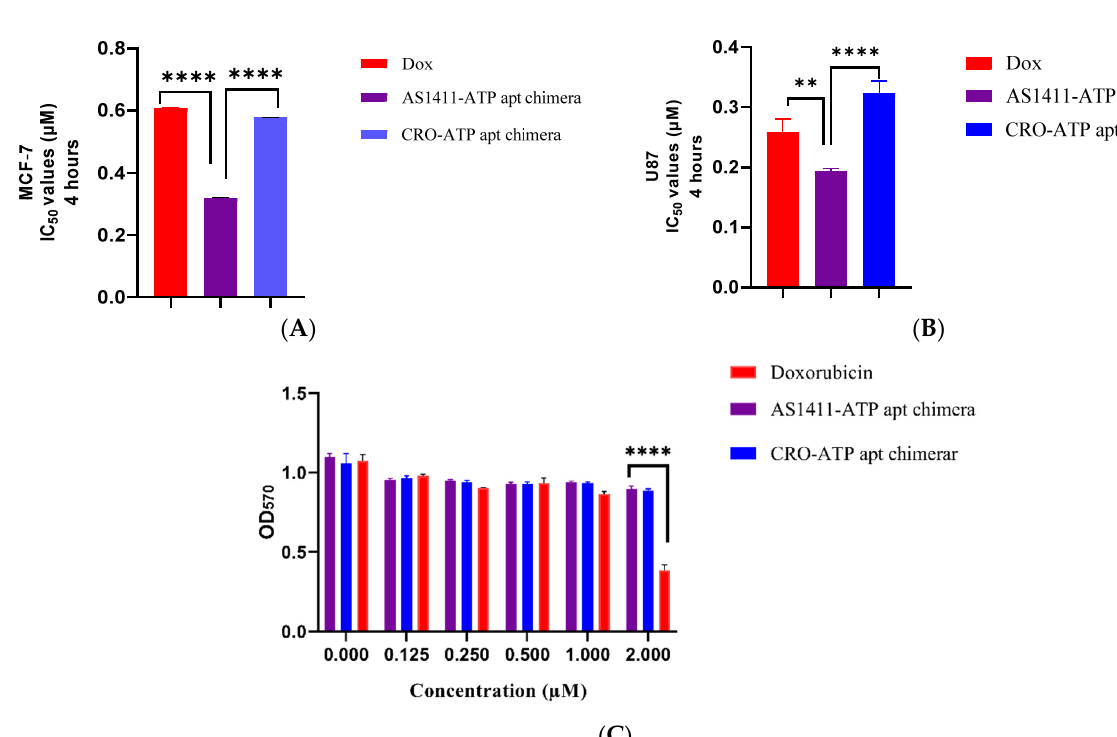
Figure 7. IC 50 values after 4 h of incubation of the chimeras with cell lines. ( A ) MCF-7 cell line. ( B ) U87 cell line. ( C ) HDF cell line. Error bars indicate SD ( n = 3). ** p < 0.01, **** p < 0.0001 (one-way ANOVA).